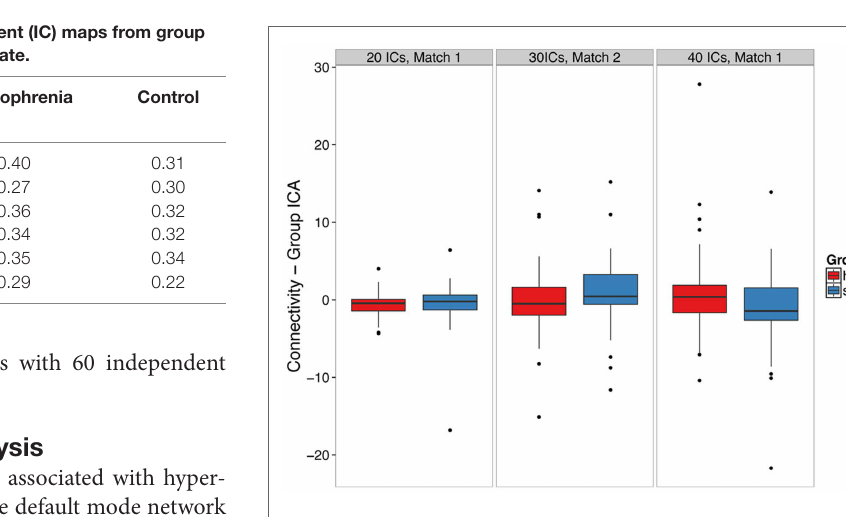
Figure 3 | group ica-derived left hippocampal hyperconnectivity depends on analysis parameters . The boxplots show the median, interquartile range, and outliers. The whiskers extend to the lowest value within 1.5 times the quartiles.